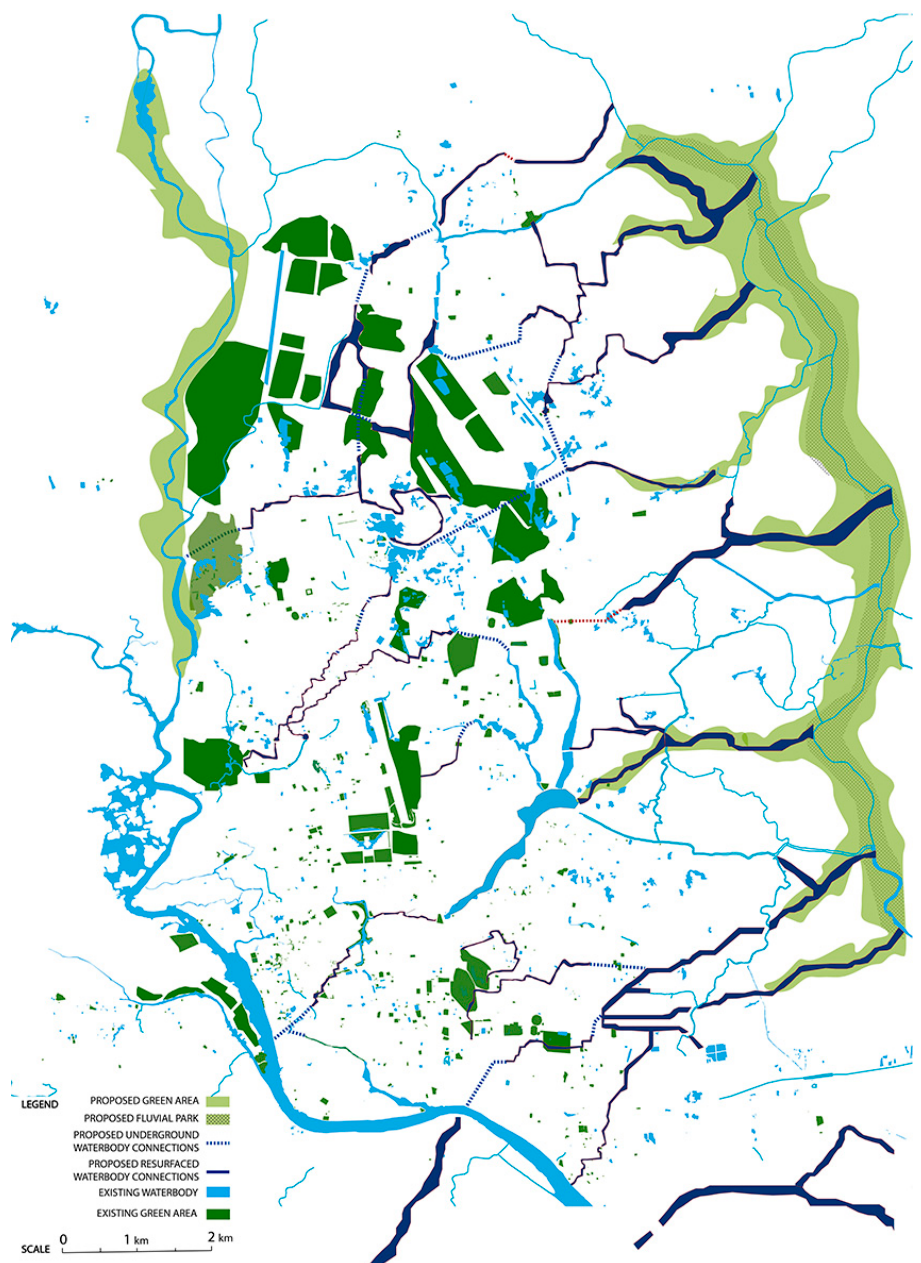
Figure 8. The proposed blue-green infrastructure (BGI) network at macro scale.